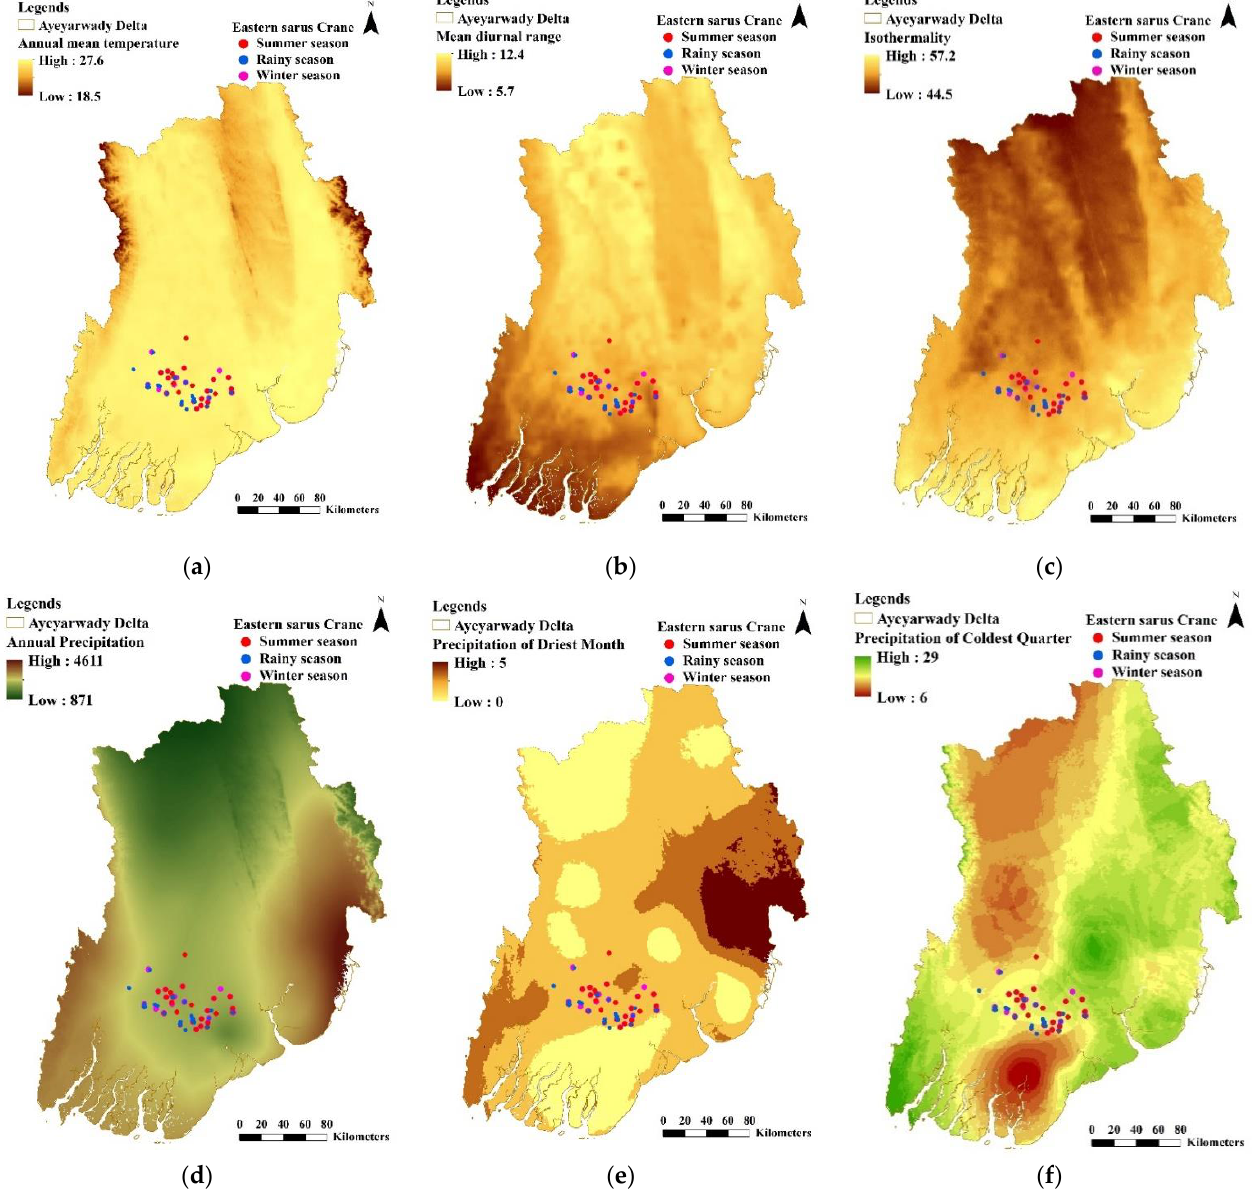
Figure 2. Climatic parameters used to create the distribution model of eastern sarus crane ( Antigone antigone sharpii ) in Ayeyarwady Delta, the Union of Myanmar; ( a ) annual mean temperature, ( b ) mean diurnal range, ( c ) isothermality, ( d ) annual precipitation, ( e ) precipitation of driest month, and ( f ) precipitation of coldest quarter.